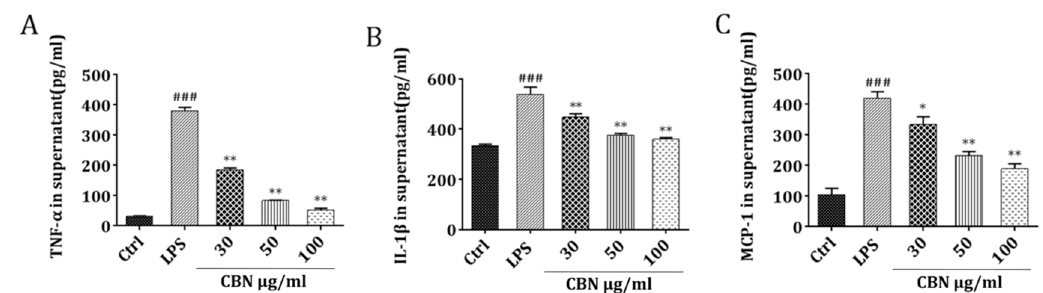
Figure 1. The effect of columbianadin (CBN) on the production of TNF- α , IL-1 β , and MCP-1 by lipopolysaccharide (LPS) stimulation. THP-1 cells were treated with CBN for 24 h post-LPS stimulation: ( A ) TNF- α , ( B ) IL-1 β , ( C ) MCP-1 levels. ### P < 0.001 versus control group; * P < 0.05 versus LPS group; ** P < 0.01 versus LPS group. The results shown are representative of three independent experiments with similar results. Data are expressed as means ± SD.